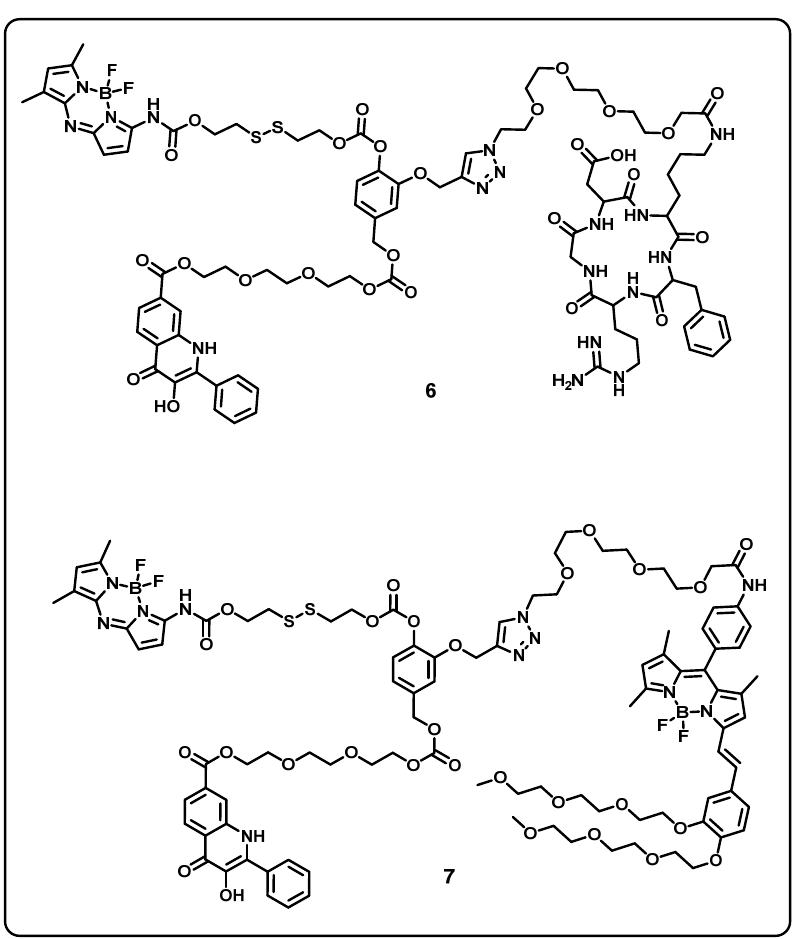
Figure 10. Structure of amino-BODIPY ( 6 and 7 ).